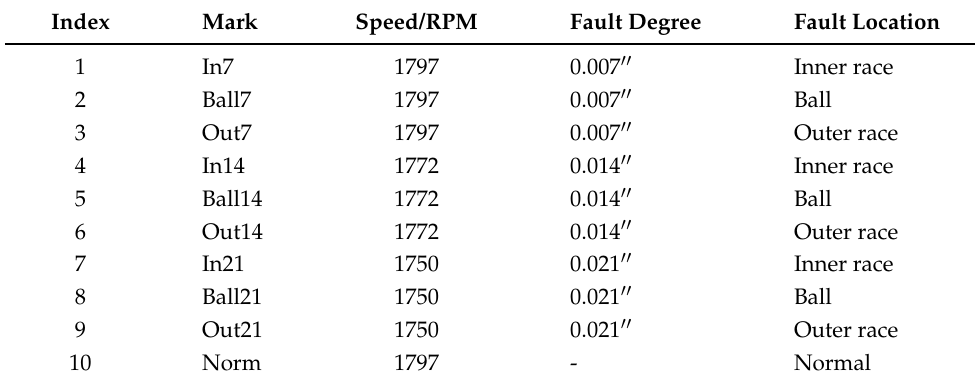
Figure 3. Case Western Reserve University bearing test bed. Table 2. Specifications of CWRU dataset.